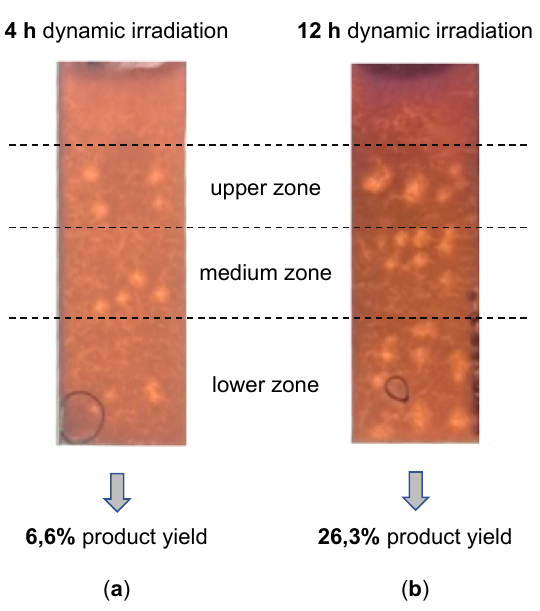
Figure 3. Doped gel after dynamic irradiation along the sample with a laser pointer during ( a ) 4 h and ( b ) 12 h. Conditions: [ 1 ] = 10 mM, [ PtOEP ] = 33 µ M, [ DPA ] = 6.7 mM, [ G-1 ] = 10 g/L, [dodecane] = 10 mM (int. std.), λ exc = 532 nm, DMF = 3 mL. Product yields were calculated by GC-FID.